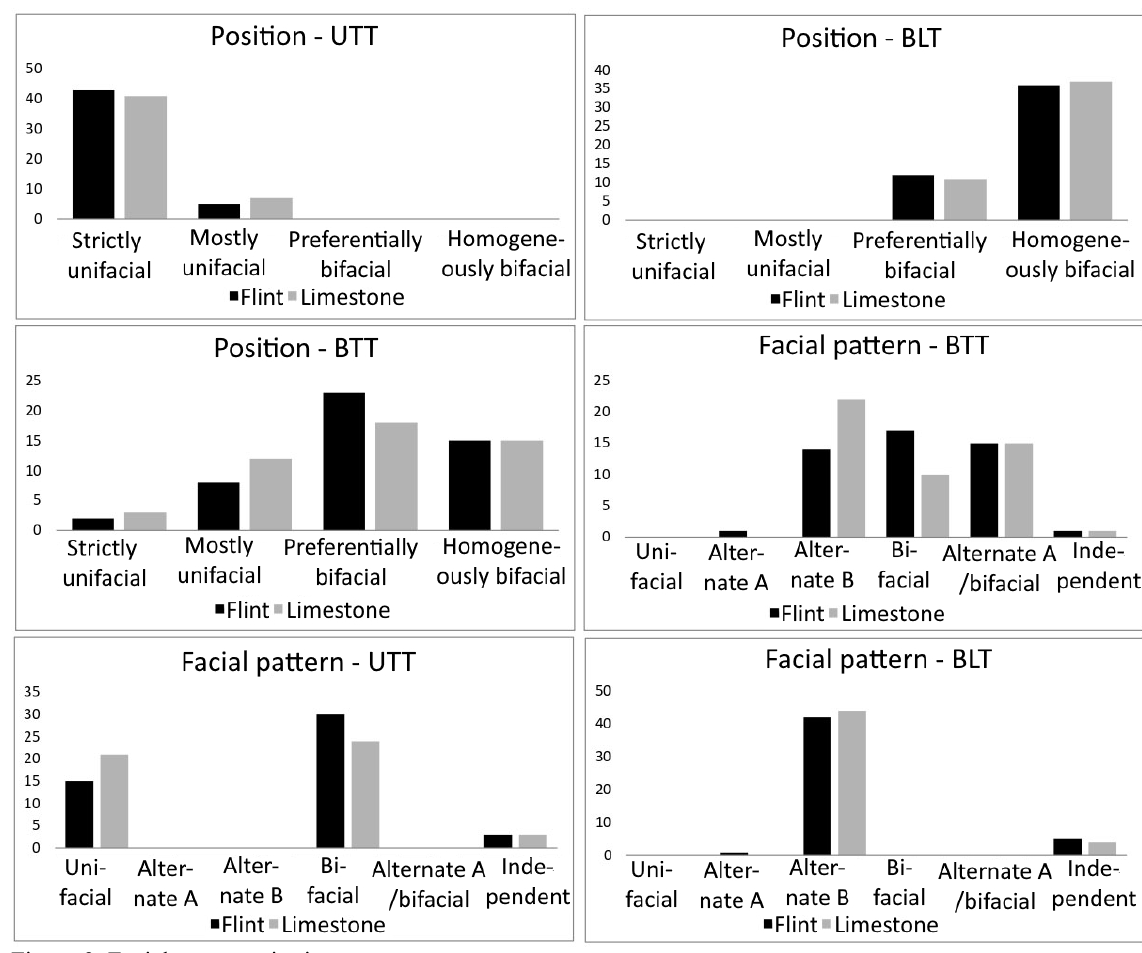
Figure 3. Facial pattern